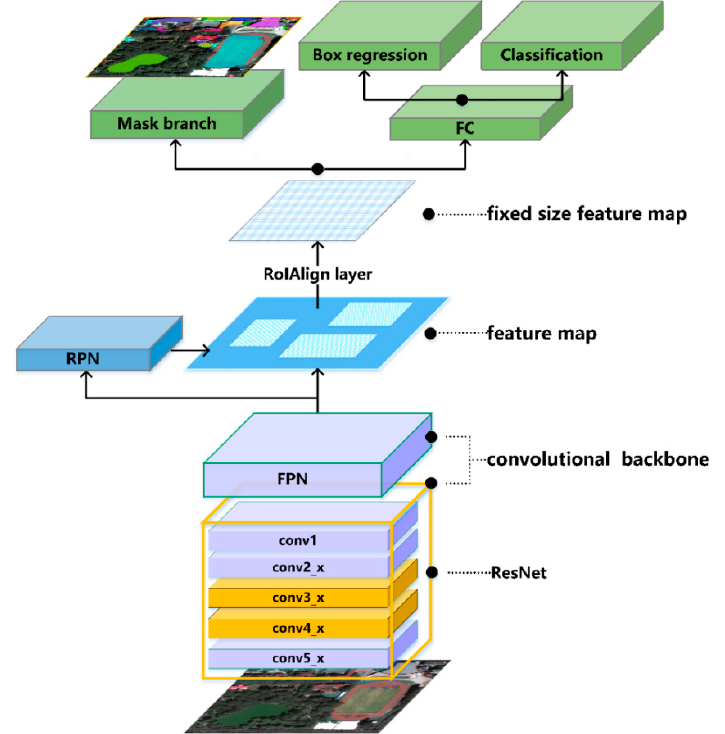
Figure 4. Mask R-CNN network architecture.